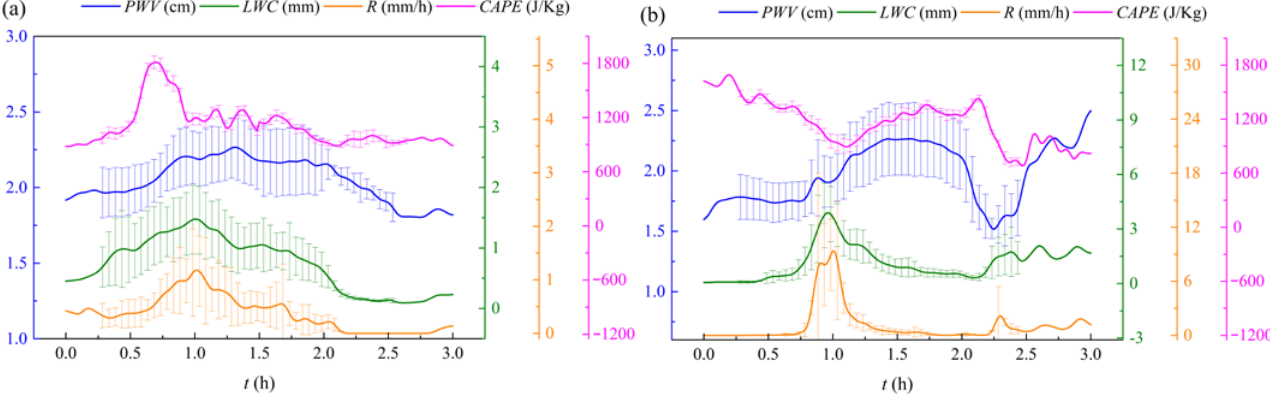
Figure 8. Temporal evolution of PWV , LWC , CAPE , and R for ( a ) stratiform precipitation and ( b ) convective–mixed precipitation.